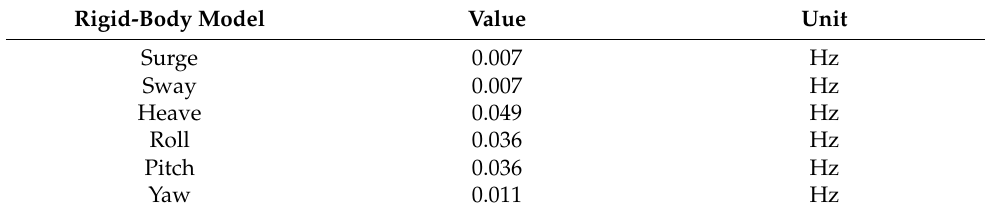
Table 2. Rigid-body natural frequencies.